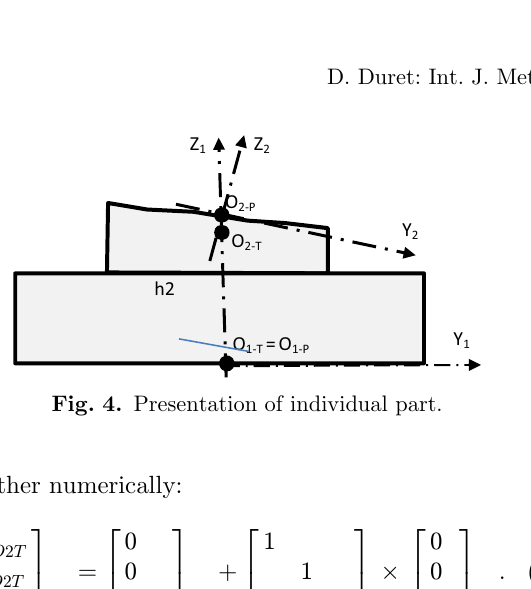
Fig. 5. Illustration of the fi eld of aligned ( R 1 target and R 1 individual). Geometrically, we